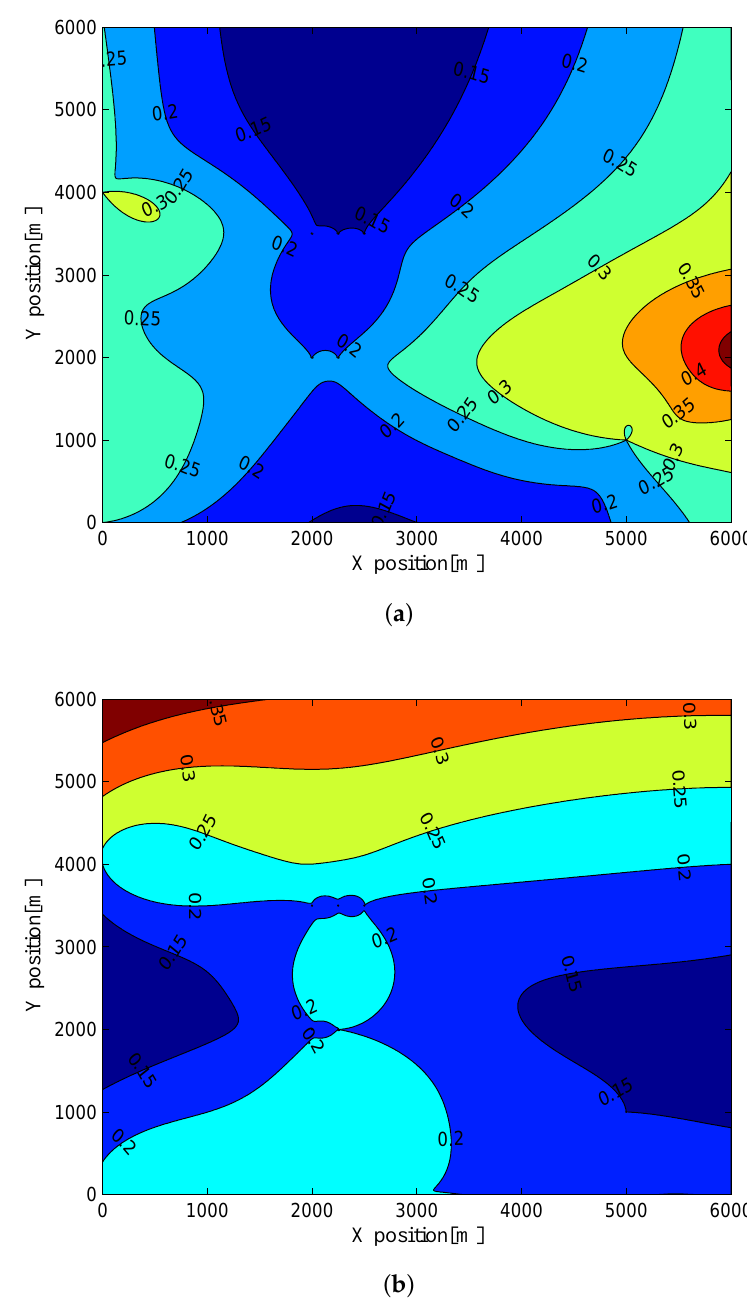
Figure 4. RMCRLB for target position dimensions in different position when SNR = 0dB and L r = 1000: ( a ) x-position; ( b )